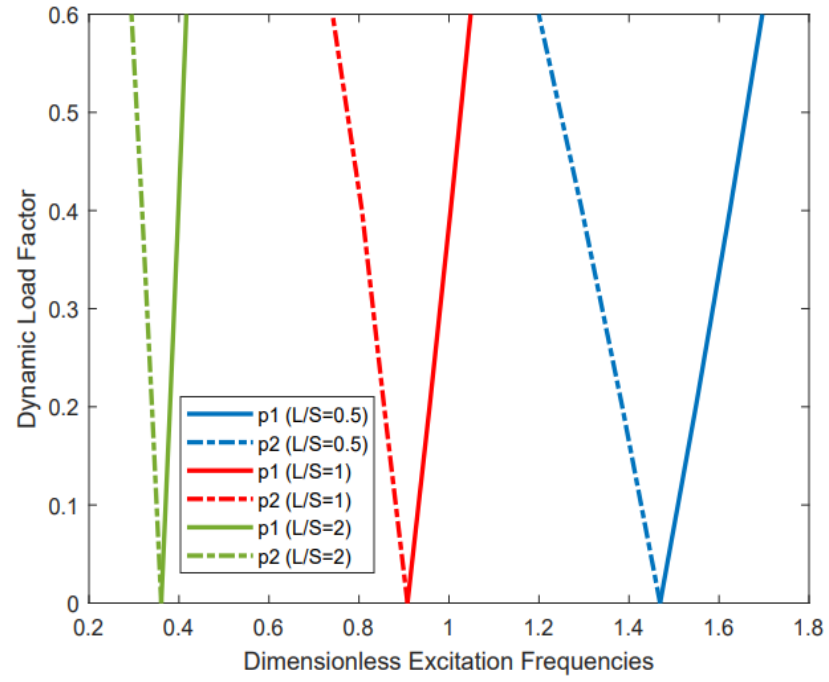
Figure 8. The effect of the L/S ratio.